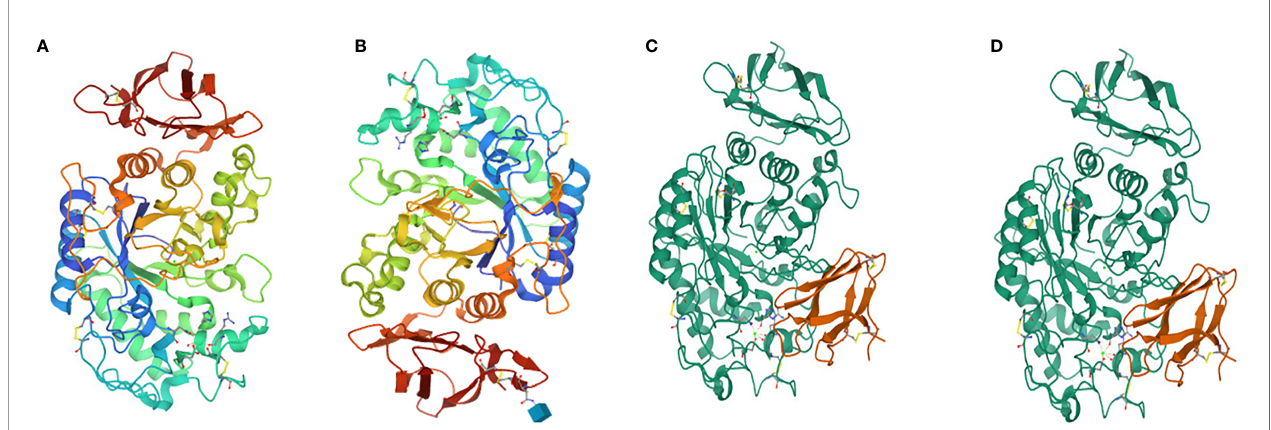
FIGURE 3 | (A) Human salivary alpha amylase, (B) human pancreatic amylase (C) alpha amylase, and (D) beta